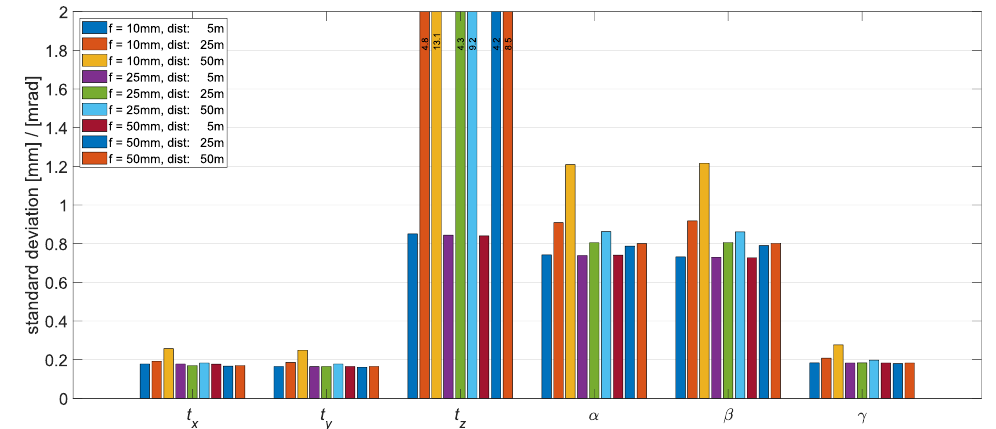
Figure 8. Standard deviations of the object pose from the Monte Carlo simulations with different focal lengths. Simulated was the 20.4MP sensor, a stereo base of 0.5m, and a 2m × 1.5m × 0.5m